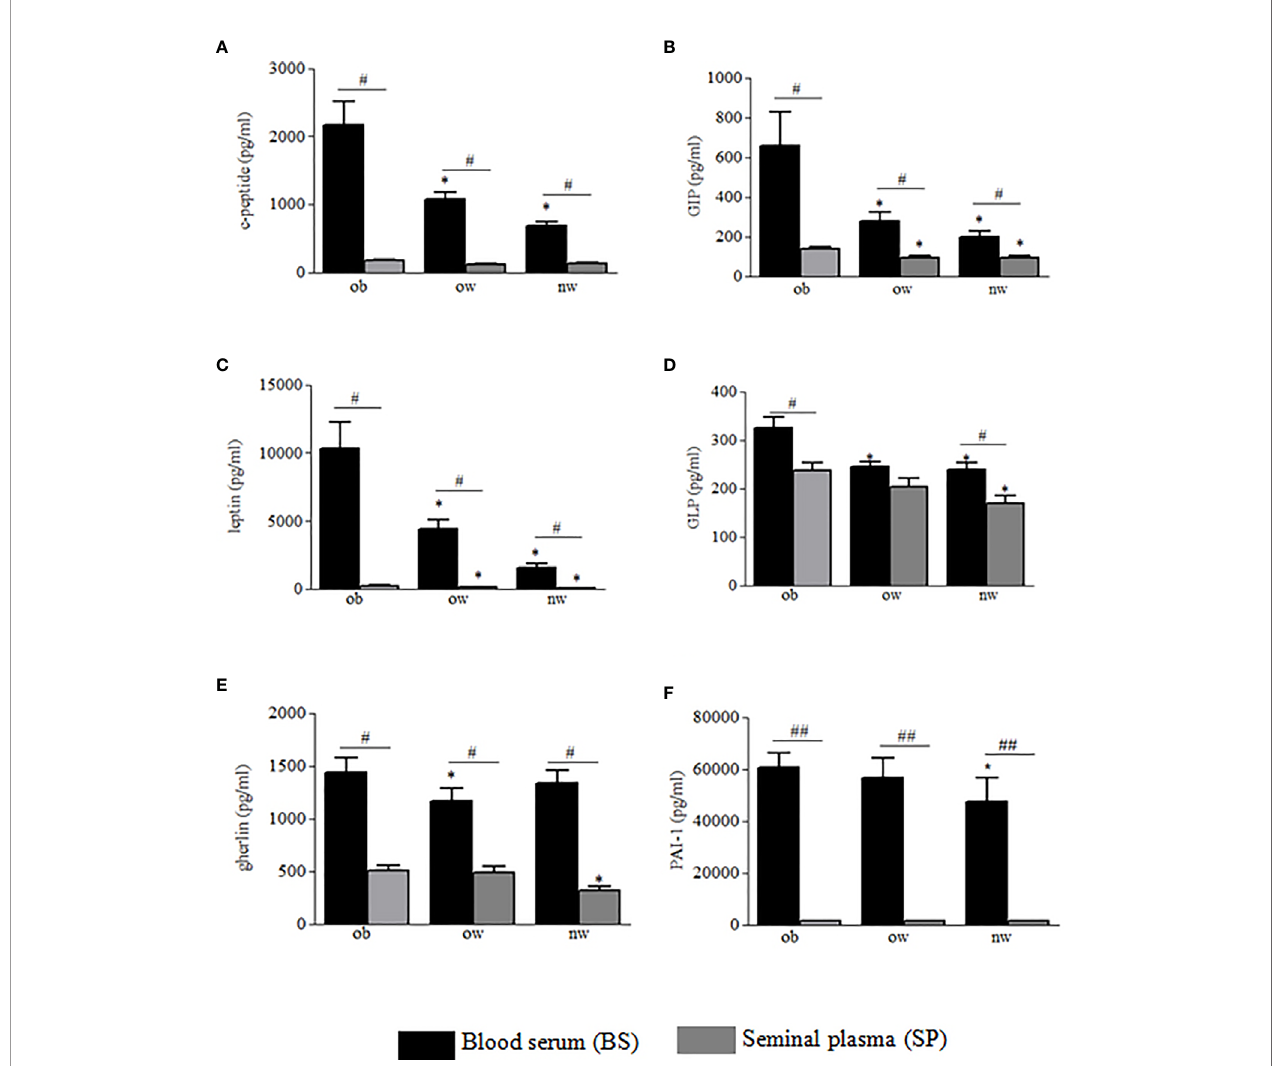
FIGURE 1 | Blood serum (black columns) and seminal plasma (gray columns) of obese, over- and normal weight subjects were analyzed for c-peptide (A) , GIP (B) , leptin (C) , GLP-1 (D) , ghrelin (E) and PAI-1 (F) . Data are presented as the means ± SE. Statistical signi fi cance was determined using ANOVA with Bonferroni ’ s post- hoc test. * P < 0.05 vs . obese subjects; P < 0.01 vs. corresponding adipokine levels between blood serum and seminal plasma. ob, obese; ow, over weight; nw, normal weight. ## P < 0.01 vs. corresponding adipokine levels between blood serum and seminal